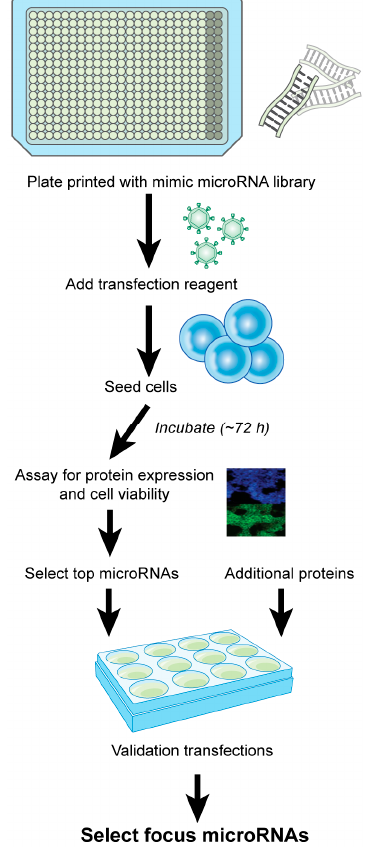
Figure 1. Example workflow for high-throughput microRNA library screen.